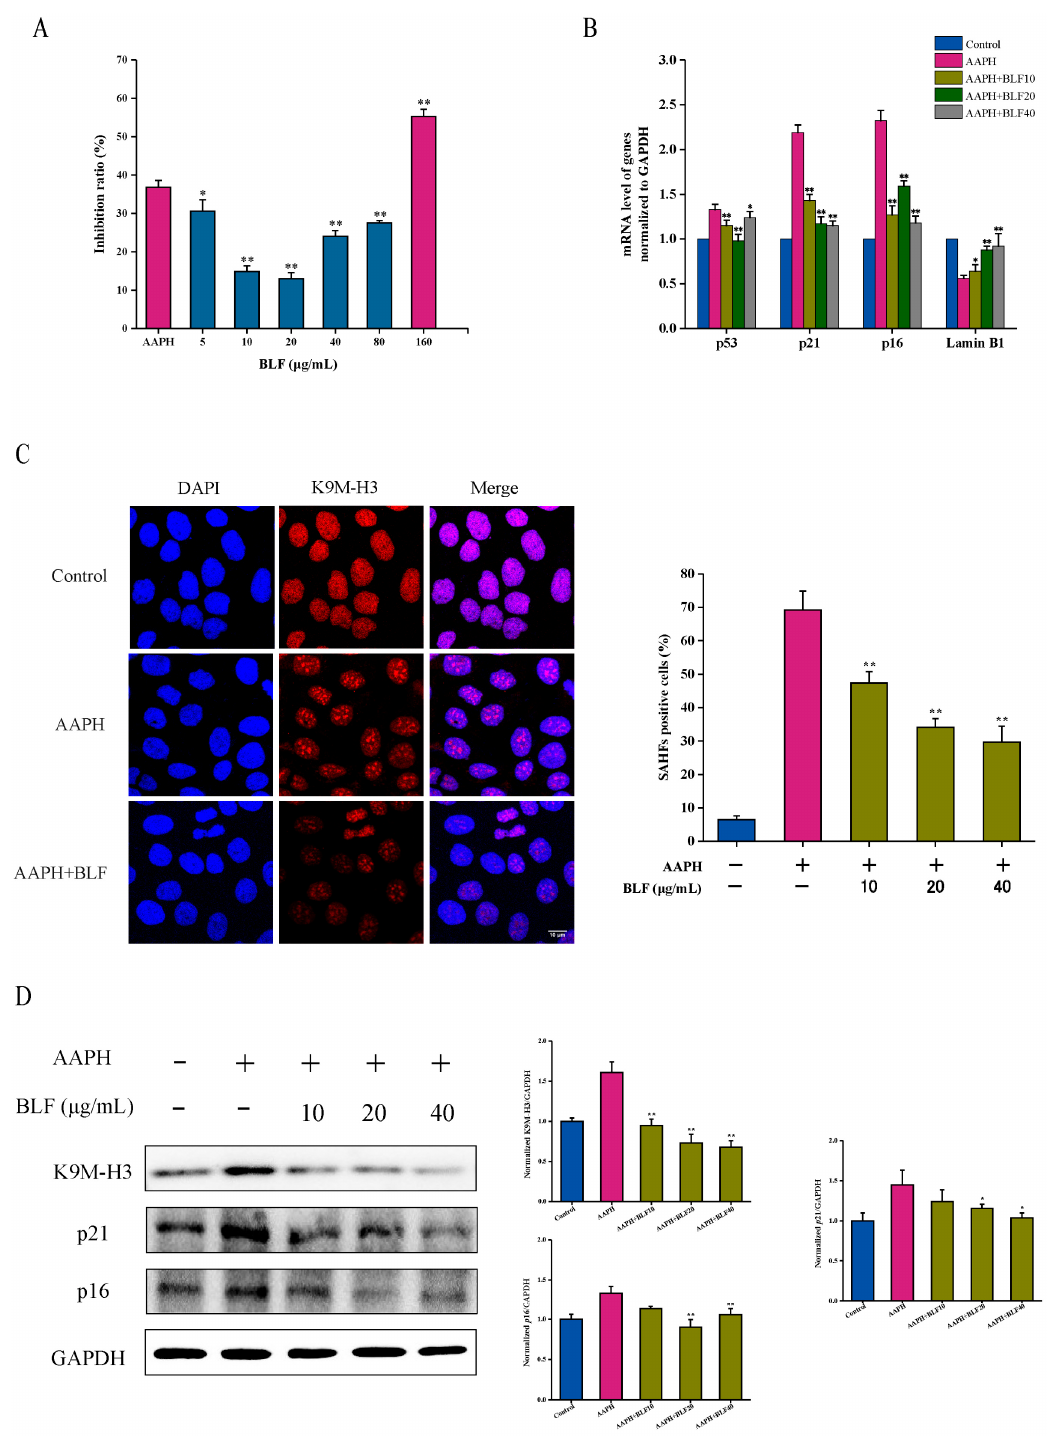
Figure 1. BLF attenuated AAPH-induced senescence of HaCaT cells. ( A ) Effects of different doses of BLF and 1 mM AAPH treatment for 48 h on the proliferation inhibition of HaCaT cells determined by the MTT assay. ( B ) Gene expression of p53, p21, p16, and Lamin B1 was determined by qRT- PCR. ( C ) Representative images of SAHF formation photographed by confocal microscope. Scale bar = 10 µ m. The percentage of SAHF positive cells is shown in the right panel. ( D ) Protein expression of p21, p16, and K9M-H3 determined by Western blotting (left). Quantitation is shown on the right. * p < 0.05, ** p < 0.01 vs. AAPH treated